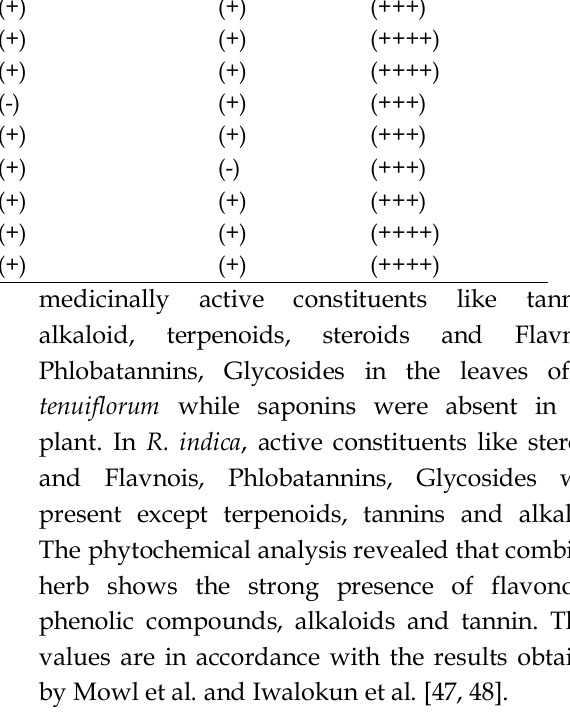
Table 2 : Proximate composition of N. arbor-tristis, H. salicifolia, O. tenuiflorum and R. indica. Proximate parameters Carbohydrate Protein Fat Crude fiber Values were expressed as mean ± S.D for 5 different preparations Table 3 : Phytochemical analysis of N. arbor-tristis, H. salicifolia, O. tenuiflorum and R. indica . Parameters